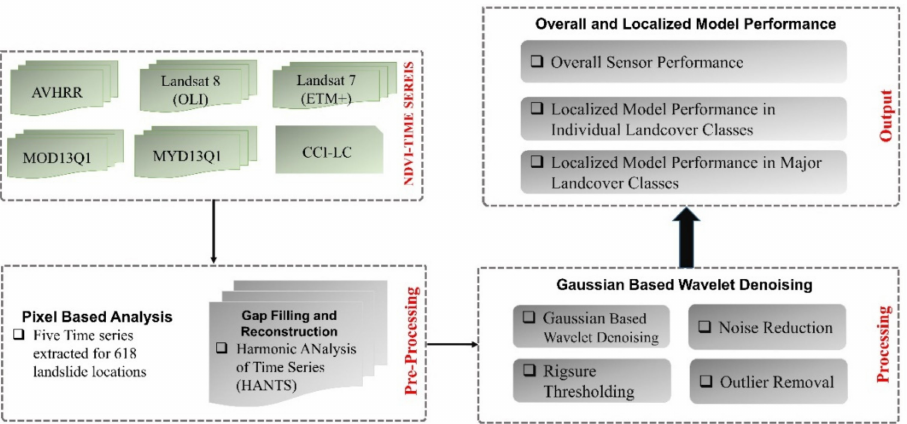
Figure 2. Schematic of adopted methodology for preprocessing (gap filling using harmonic analysis of time series) and denoising (using wavelet threshold denoising) of the five NDVI time series used in this